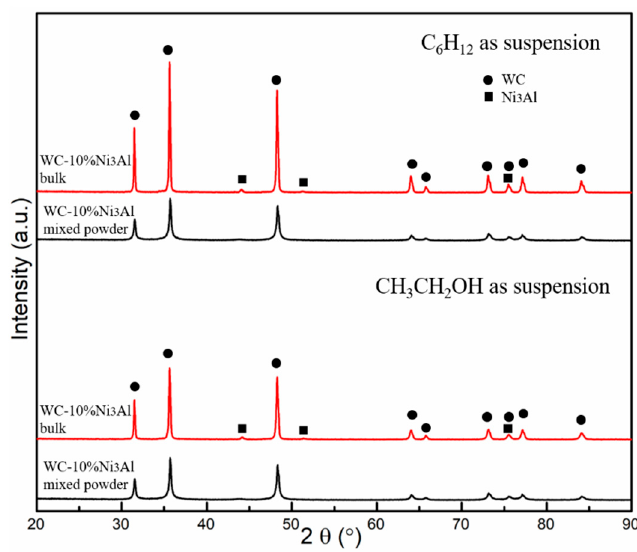
Figure 1. X-ray di ff raction (XRD) patterns of WC-10Ni 3 Al mixed powder and bulk using di ff erent Figure 1. X-ray diffraction (XRD) patterns of WC-10Ni 3 Al mixed powder and bulk using different ball-milling ball-milling suspensions.